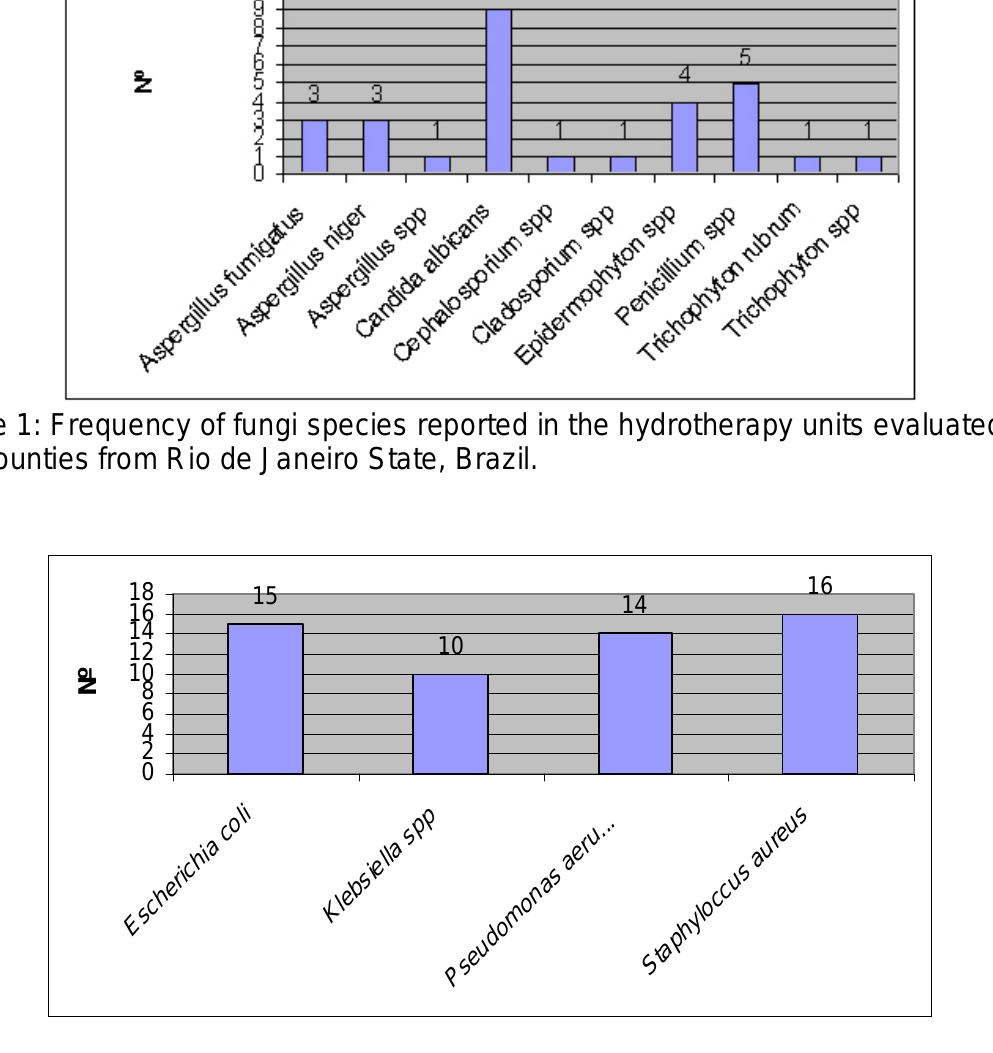
Figure 2: Frequency of bacteria species reported in the hydrotherapy units evaluated in two counties from Rio de Janeiro State,